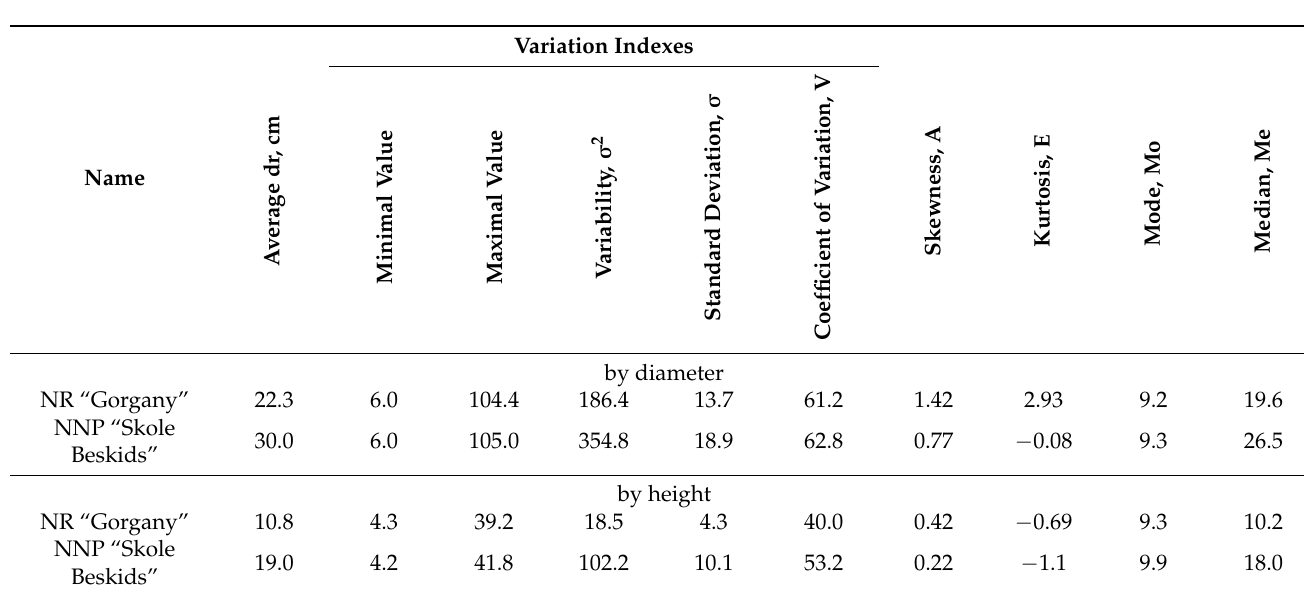
Table 3. The main biometrical indexes of the forest stands.